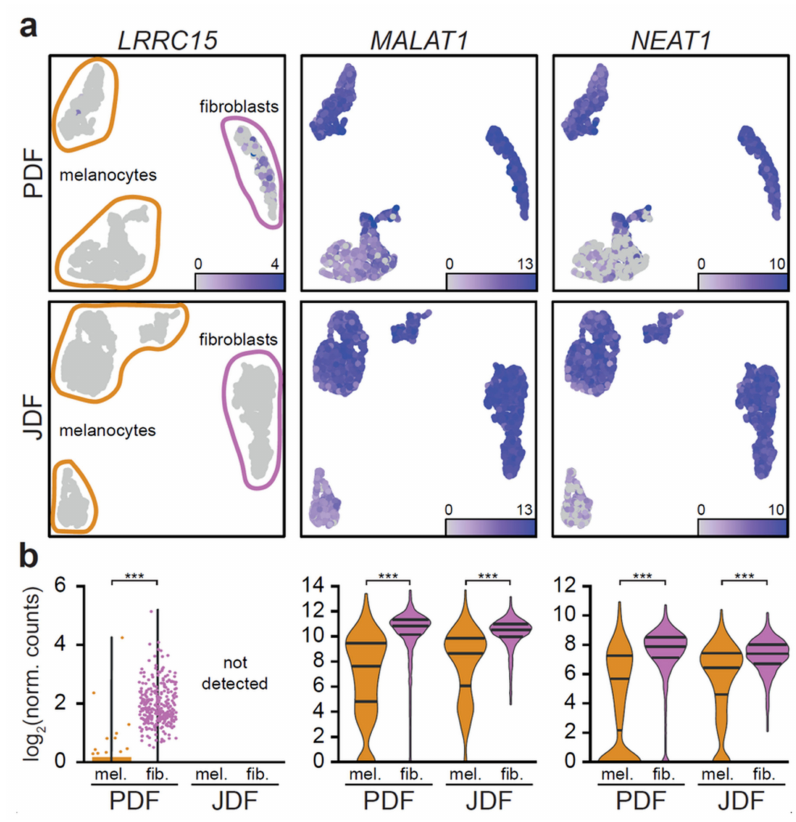
Figure 5. Expression of MALAT1 and NEAT1 distinguishes two melanoma cell clusters in each spheroid type. In UMAP projection of the data ( a ), LRRC15 (left) is expressed only in the ECM + cluster of PDF (top) fibroblasts. MALAT1 (centre), and NEAT1 (right) display expression predominantly in the upper cluster of melanoma cells both in PDF (top) and JDF (bottom). ( b ) The expression intensities of the genes are di ff erent in fibroblasts and melanoma cells, with markedly bimodal distribution in melanoma cells (*** p < 0.001, Mann-Whitney U